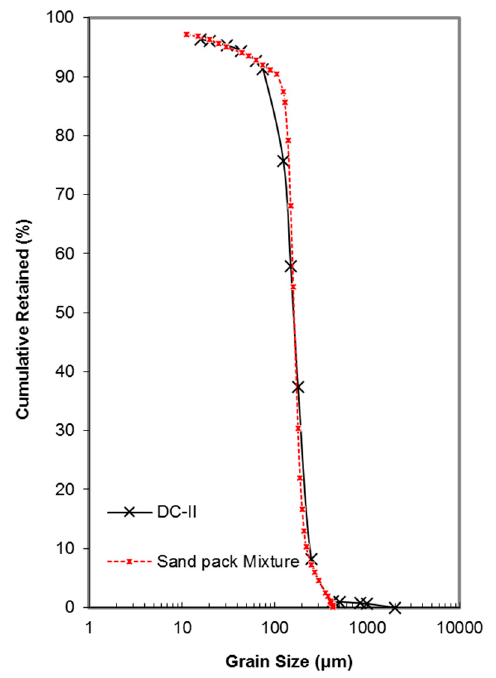
Figure 5. The PSD of Class Ⅱ Devon Pike 1 and the synthetic sand pack.